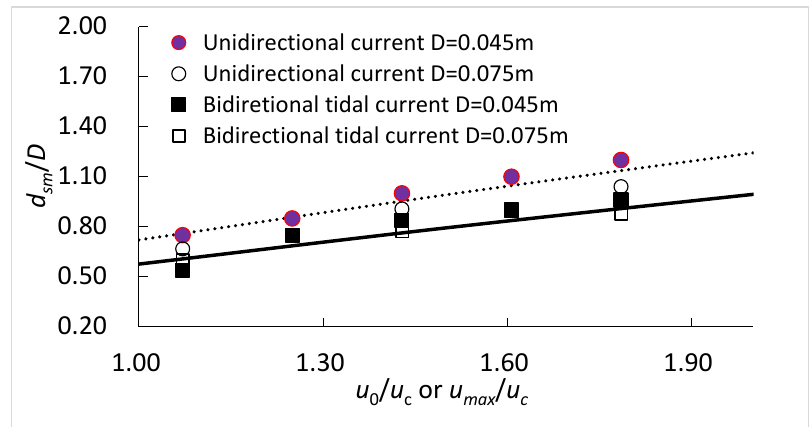
Figure 10. Dimensionless maximum scour depth d sm /D under different flow conditions.